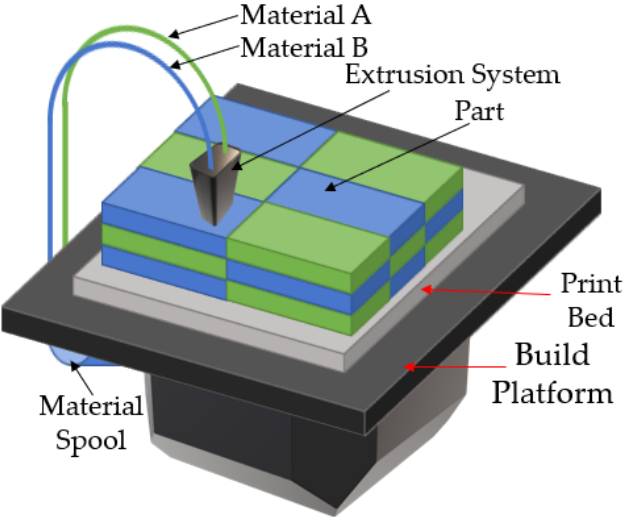
Figure 3. A diagram showing the fused-deposition process [50] Copyright 2016 Copyright Elsevier Ltd..